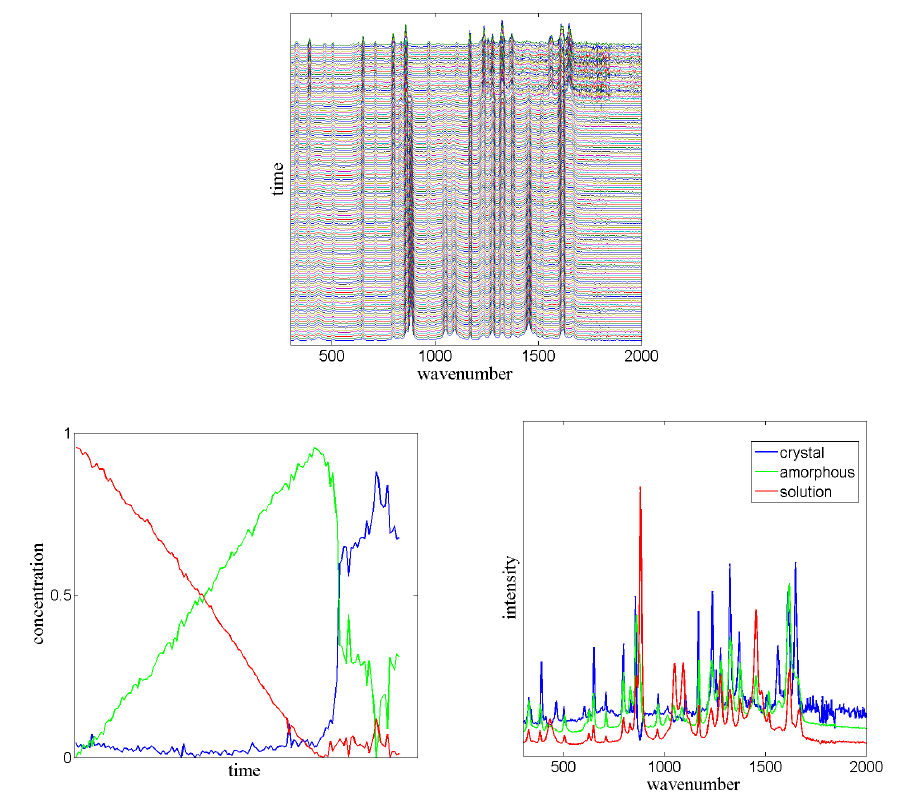
Figure 7. Top: In sequential spectroscopy many spectra are measured in a certain time interval (matrix V ). Each line in the plot corresponds to one Raman spectrum measured at a certain point of time from a crystallization process of paracetamol in ethanol (wavenumbers in cm − 1 ). The unpublished data V has been measured by Surahit Chewle [49]. Bottom Left: With the aid of X and ¯ P received from V one can derive the concentration χ of the “pure” spectra at each point of time via PCCA+. Bottom Right: Using this matrix χ the “pure” spectra are calculated as W = χ # V . From this calculation one can identify the intermediate steps of crystallization of